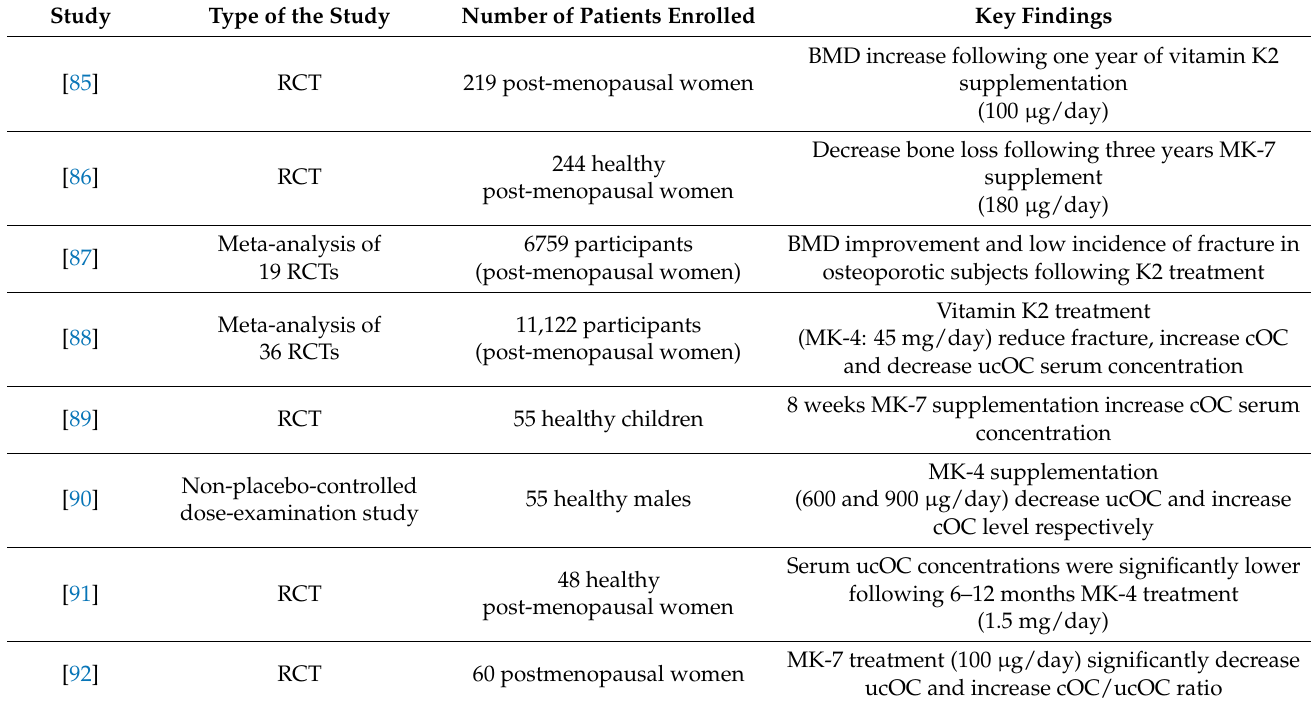
Table 2. Clinical evidence linking vitamin K2 supplementation and bone